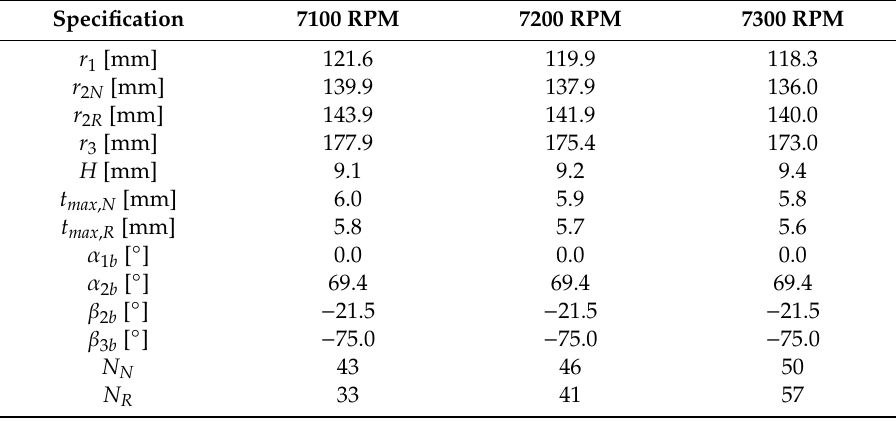
Table 2. Preliminary design results of the radial outflow turbine.